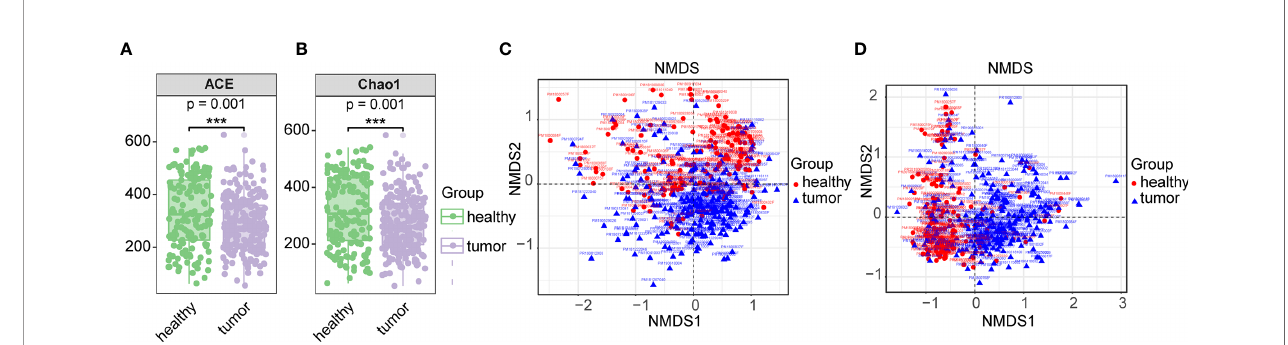
FIGURE 1 | Comparison of gut microbiome between CRC and healthy gut. (A) Alpha diversity communities based on observed OTUs by richness (Chao1, ACE). (B) Beta diversity measured by unweighted unifrac. (C) Beta diversity measured by unweighted unifrac. (D) Beta diversity measured by weighted unifrac. Overall differences in the microbiome composition among groups were assessed by ANOSIM. *** means biological signi fi